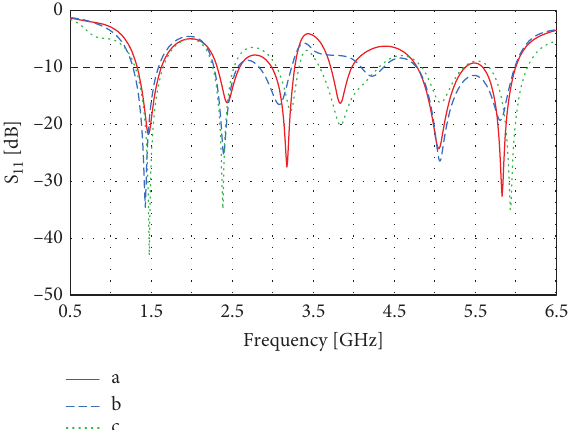
Figure 12: Comparison of return loss under different shapes of ground plates.